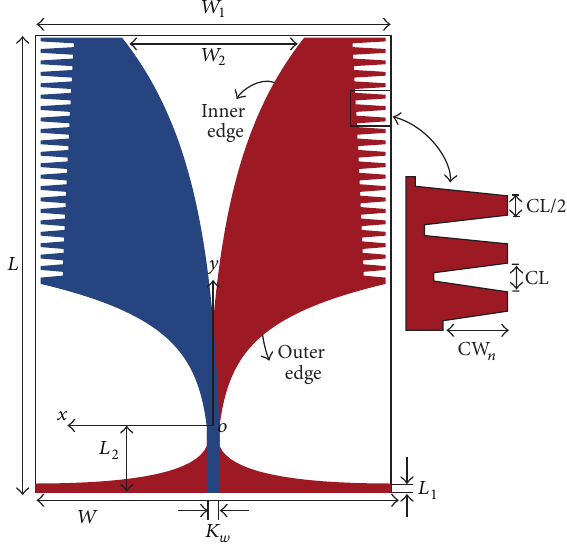
Figure 1: Geometry of the designed antenna element.